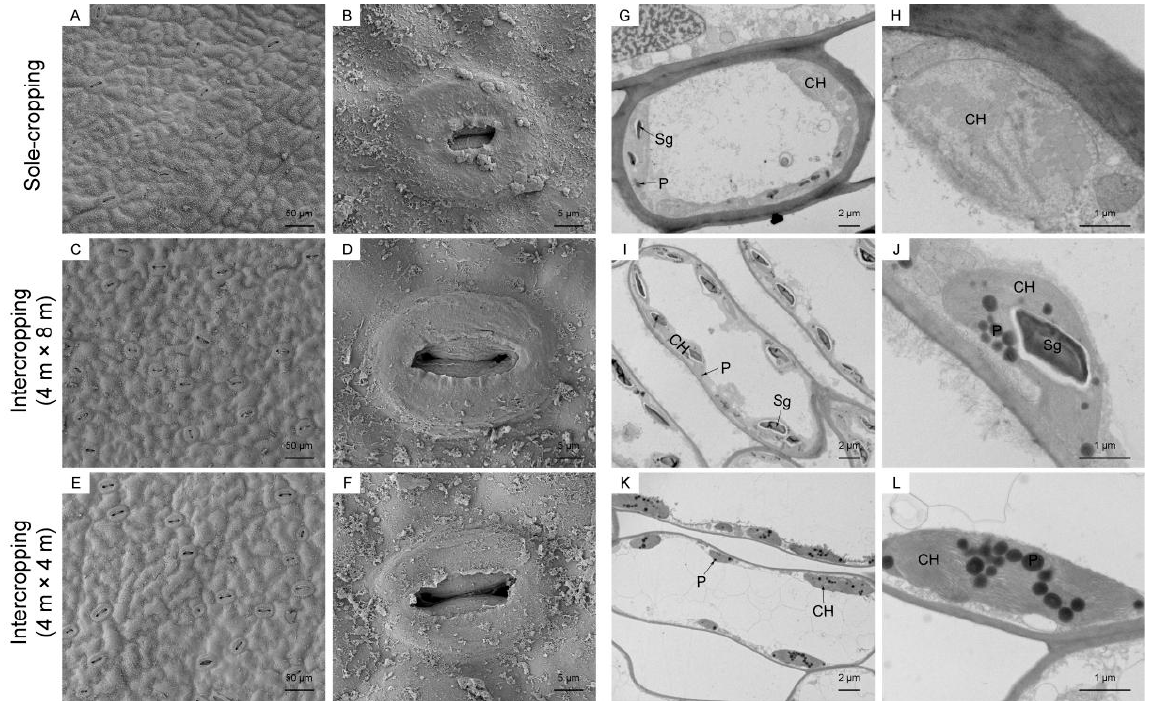
Figure 7. Effects of understory cultivation on the anatomical structures of P. ostii : ( A – F ), SEM image of the leaf lower epidermis and its stomata; ( G – L ), TEM image of mesophyll cells and its chloroplasts. ( A , B , G , H ) sole-cropping P. ostii ; ( C , D , I , J ) intercropping P. ostii under C. illinoinensis with row spacing of 4 m × 8 m; ( E , F , K , L ) intercropping P. ostii under C. illinoinensis with row spacing of 4 m × 4 m. Sg, starch granule; P, plastid pellet; CH, chloroplasts.